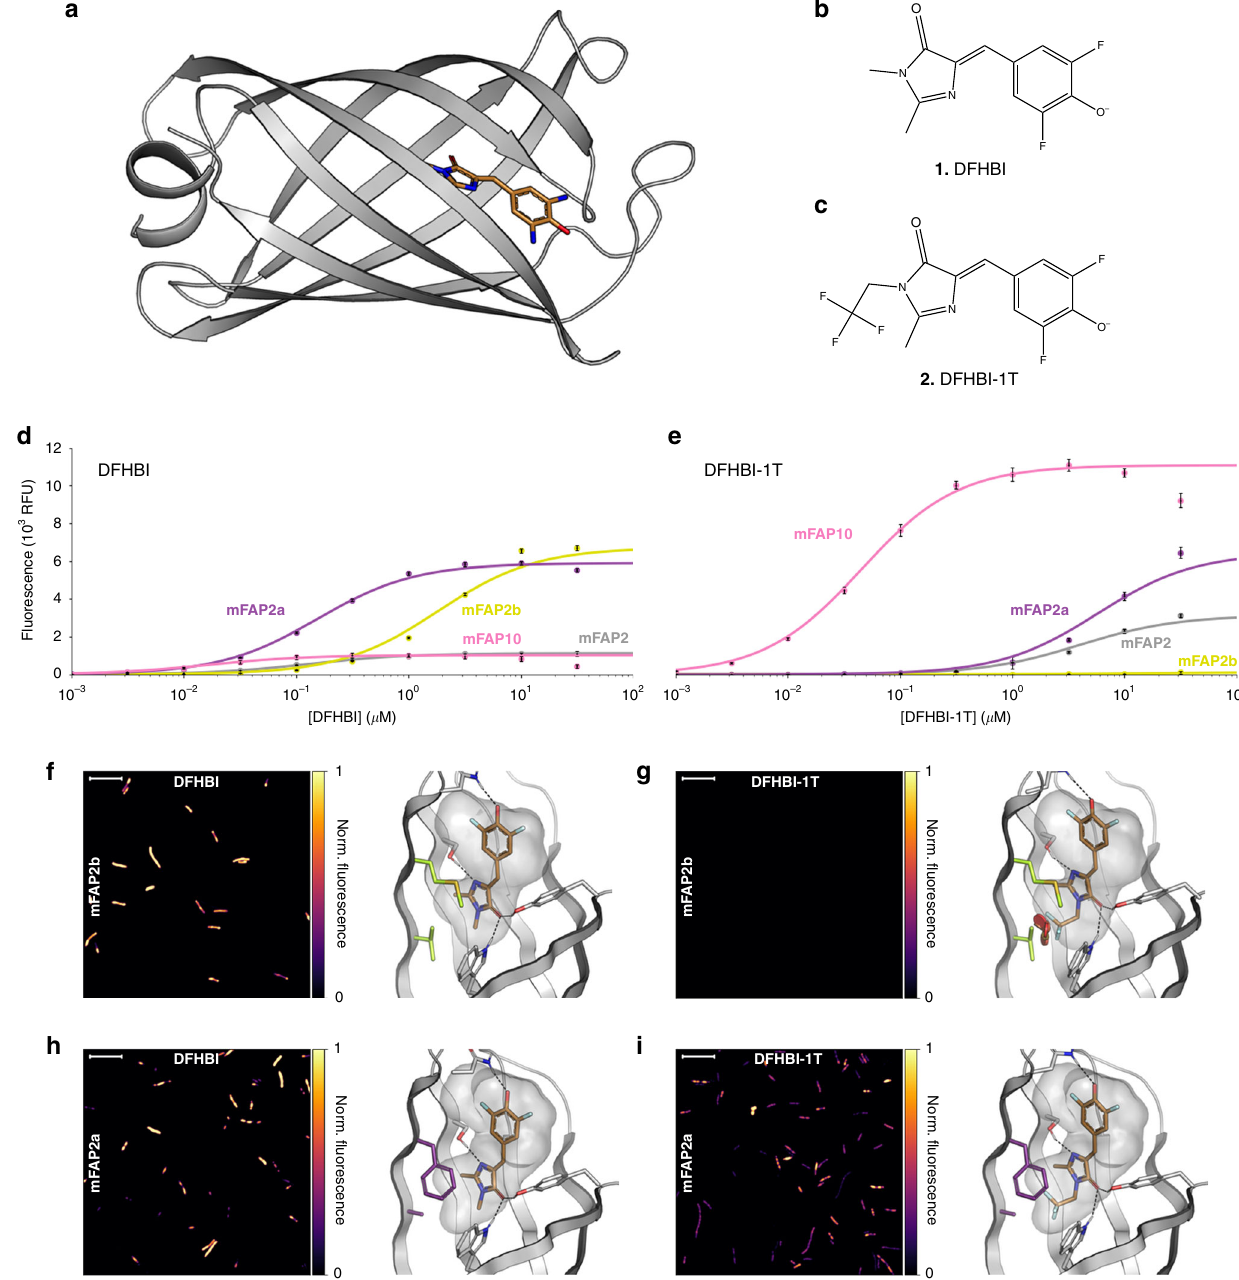
Fig. 1 Characterization of brighter and chromophore-speci fi c mFAPs. a Computational model of de novo designed β -barrel variant mFAP2b showing protein backbone (cartoon) and bound DFHBI chromophore (sticks) . b , c Chemical structures of DFHBI and DFHBI-1T, respectively. d , e In vitro titration of d DFHBI or e DFHBI-1T with mFAP2 (gray) , mFAP2b (lime) , mFAP2a (violet) , and mFAP10 (pink) proteins. Error bars represent s.d. of the mean of eight technical replicates. Normalized means were fi t to a single-binding site isotherm function using non-linear least squares fi tting to obtain K d values (Table 1), and the fi ts scaled to the maximum mean relative fl uorescence unit (RFU) values (lines) . f – i Each panel shows a representative image of the fl uorescence signal emitted by E. coli cells expressing the indicated mFAP variant labeled with 10.0 µ M concentration of the indicated chromophore (left) and a zoom-in of the modeled-binding pocket of that mFAP variant bound to the chromophore (right) . The images (left) are the pseudocolored normalized fl uorescence intensity per pixel. Scale bars represent 10 microns. Imaging was independently repeated twice with similar results. The computational models (right) show the residues unique to mFAP2b (V13, M15) (lime sticks) or mFAP2a (A13, F15) (violet sticks) . Intermolecular hydrogen bonds to the chromophore are shown as black dotted lines. Vacuum electrostatic contact potential around the chromophore is shown in a transparent gray surface. f mFAP2b with DFHBI, g mFAP2b with DFHBI-1T does not emit a detectable fl uorescence signal because binding is precluded by steric clashes of DFHBI-1T with V13 (red cylinders) , h mFAP2a with DFHBI, and i mFAP2a with DFHBI-1T. Source data is available for Fig. 1f –